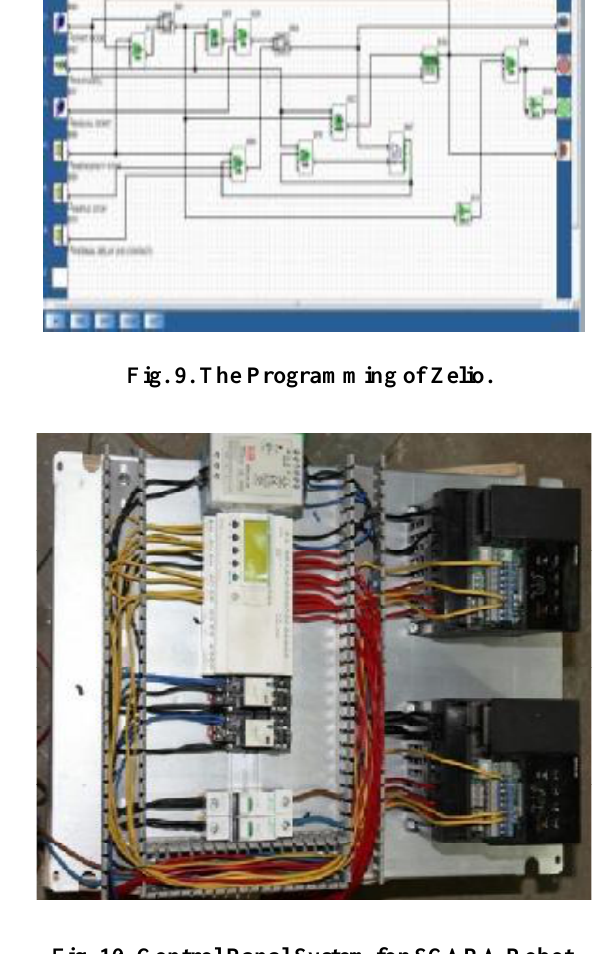
Fig. 10. Control Panal System for SCARA